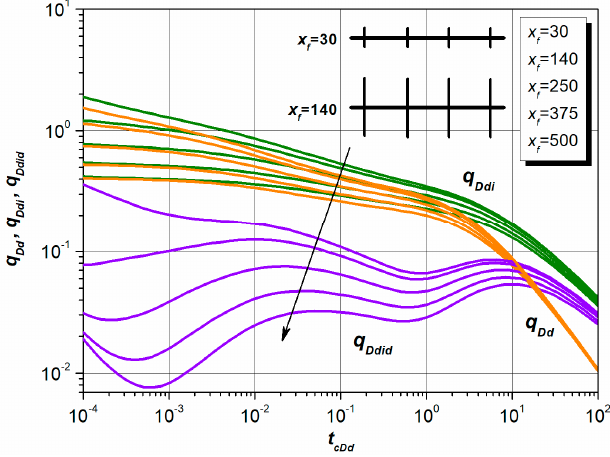
Figure 4. The effect of total length of fractures on combined type curves of an MFHW.